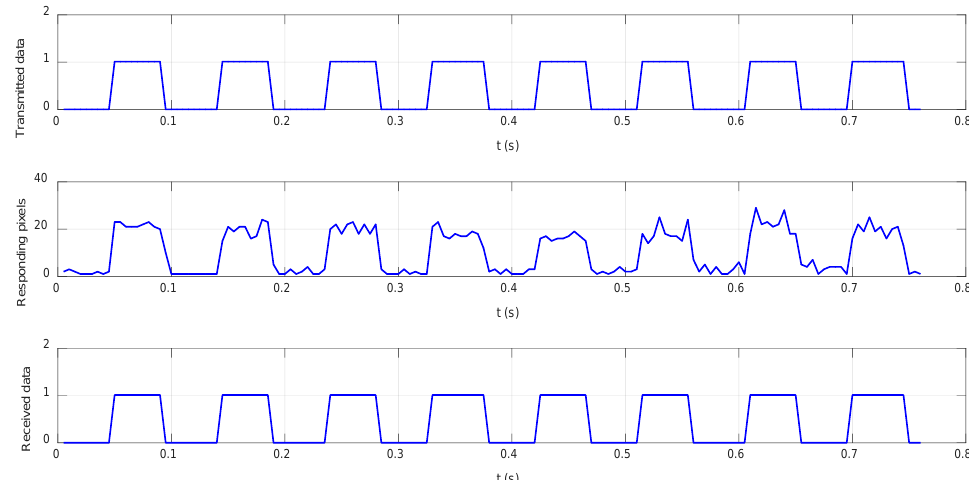
Figure 22. Results of the reflective communication experiment.